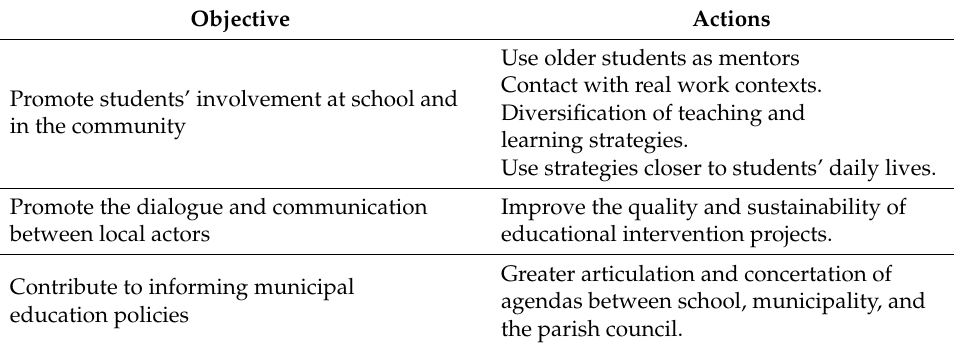
Table 4. Study’ specific objectives and related